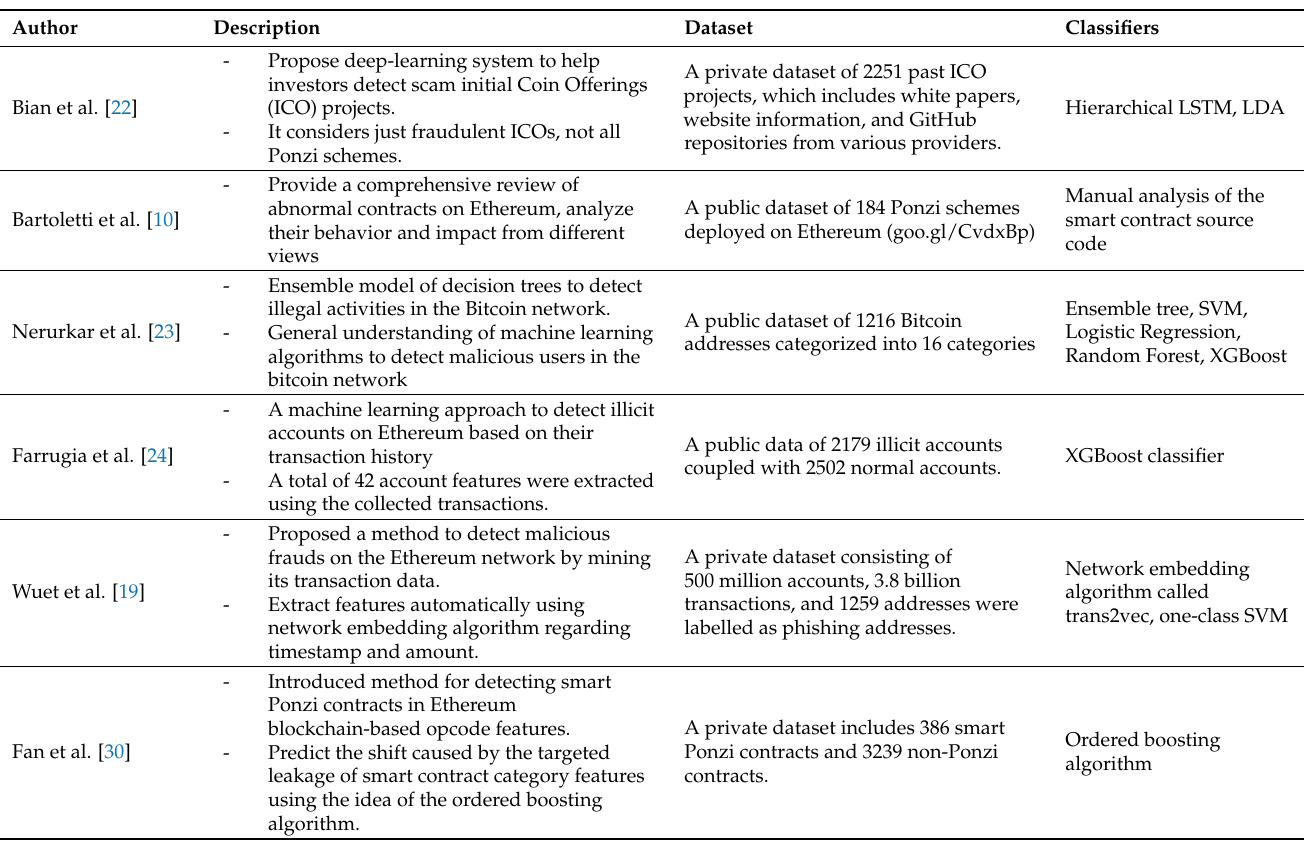
Table 1. Summary of the literature